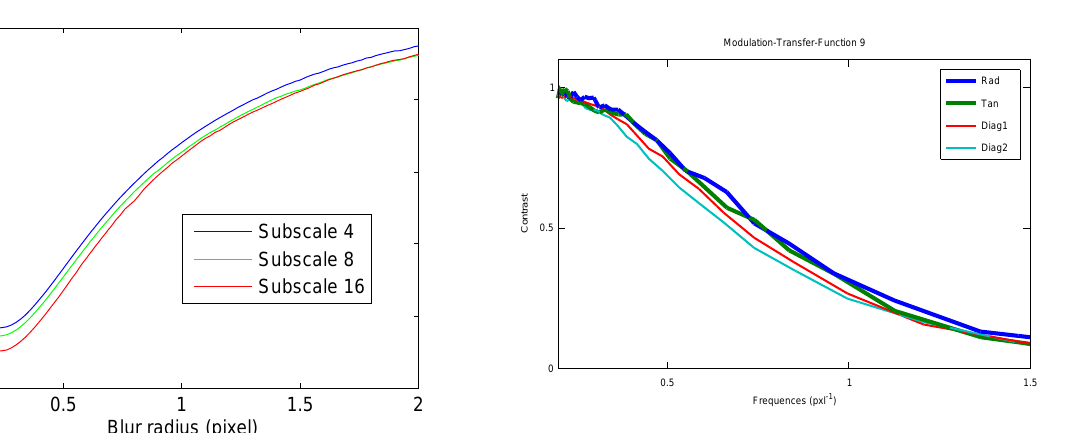
Figure 4: Ratios of ¯ E max values for subsampled aerial images.